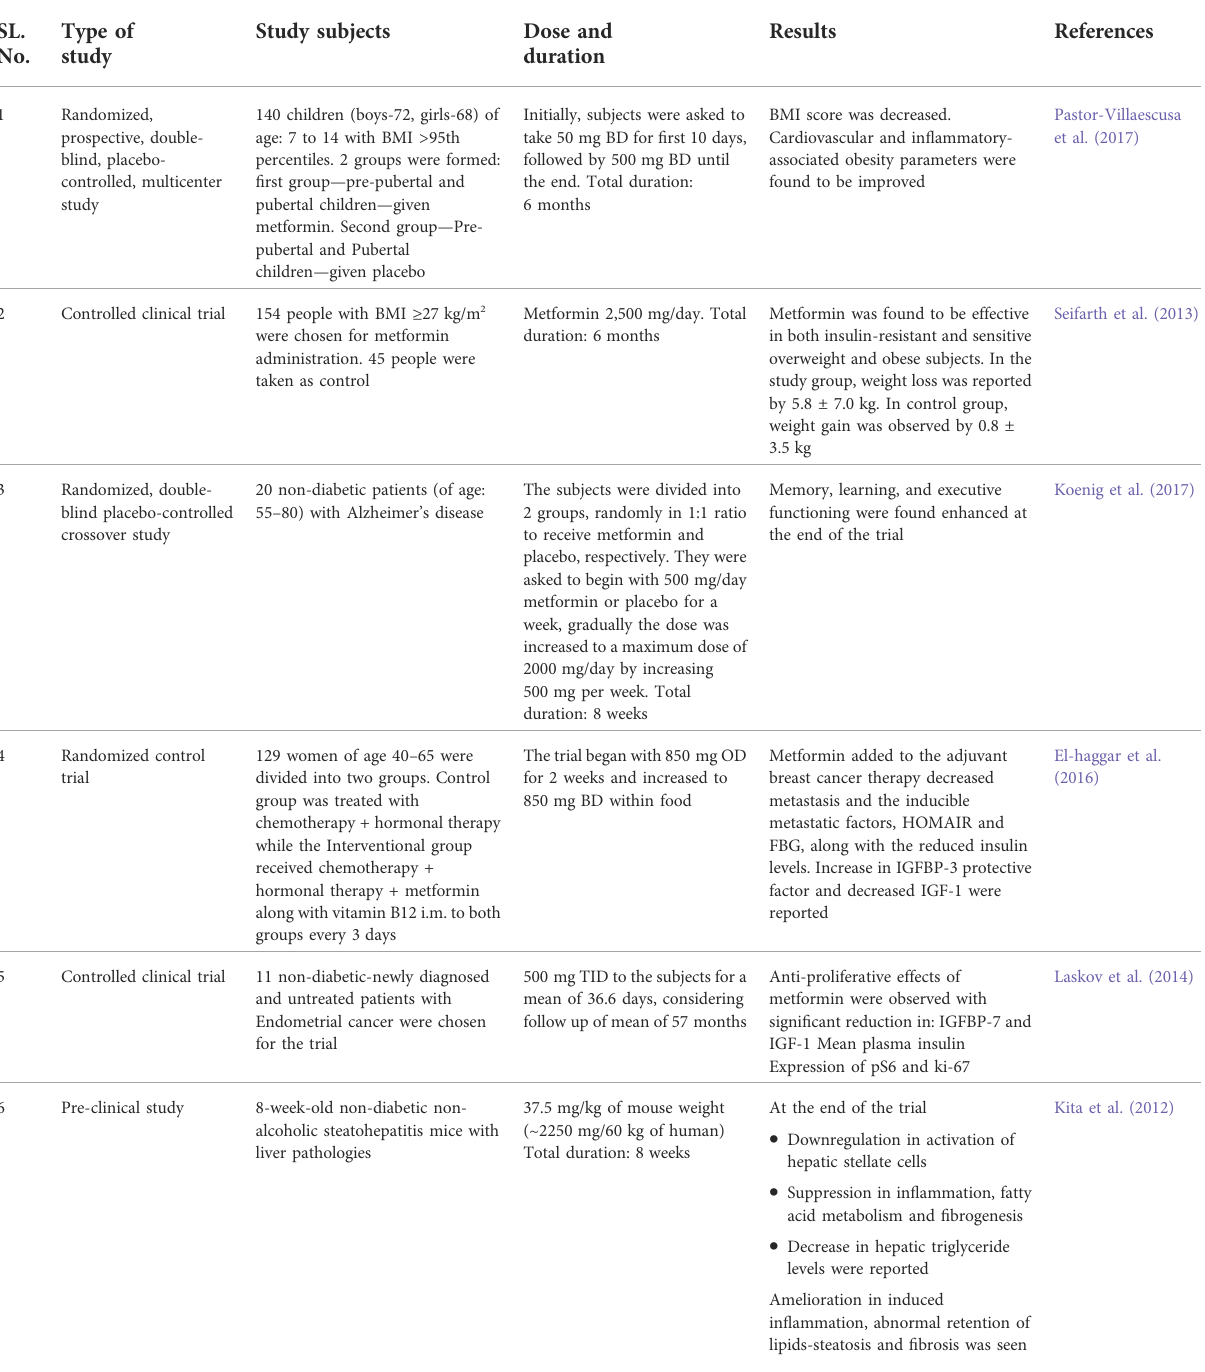
TABLE 1 Reported studies of metformin in the treatment of different diseases. SL.